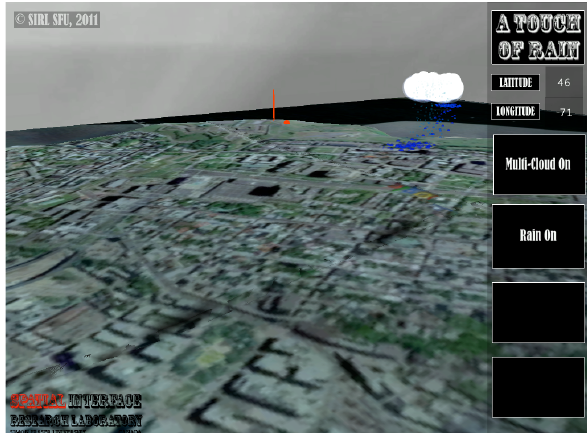
Figure 4. A Situated Touch of Rain in single user mode with orthoimagery overlaid on a DEM. The user’s real-time